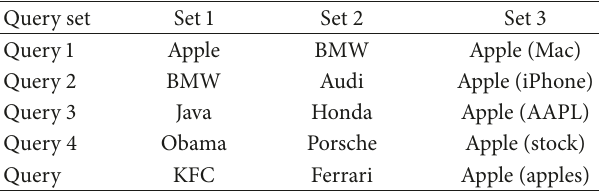
Table 4: The queries used for tuning and evaluating our